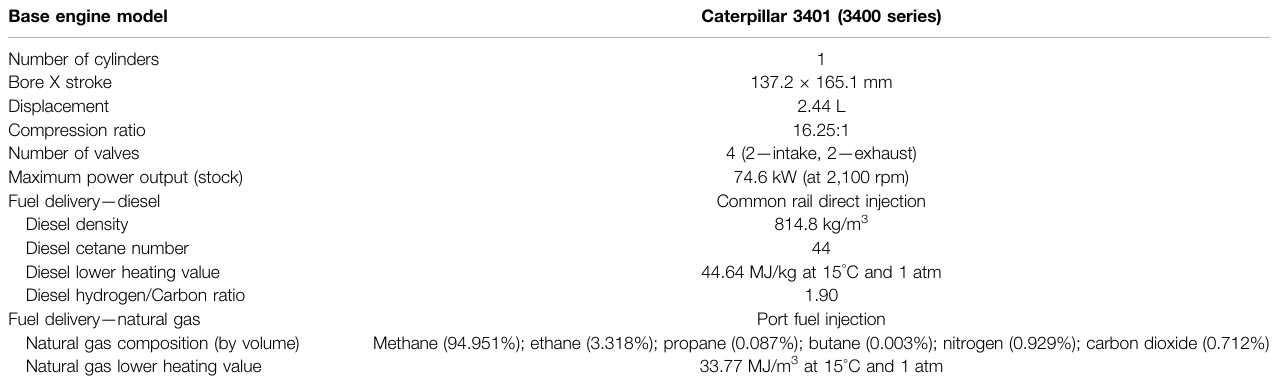
TABLE 1 | Test engine speci fi cations and fuel properties.